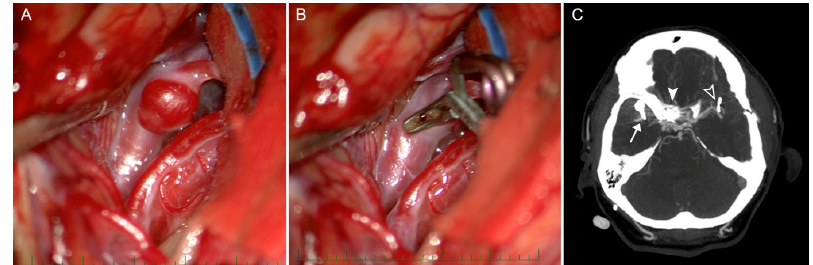
Figure 3. Clipping of an unruptured left M2 aneurysm. ( A ). Intraoperative view of the left unruptured M2 aneurysm. ( B ). Intraoperative view after successful clipping the M2 aneurysm. ( C ). CTA after final treatment: a clip of a ruptured right M12 bifurcations (arrow), coiling of the right distal A1 (full white arrowhead) and a clip of unruptured left M2 (empty arrowhead).